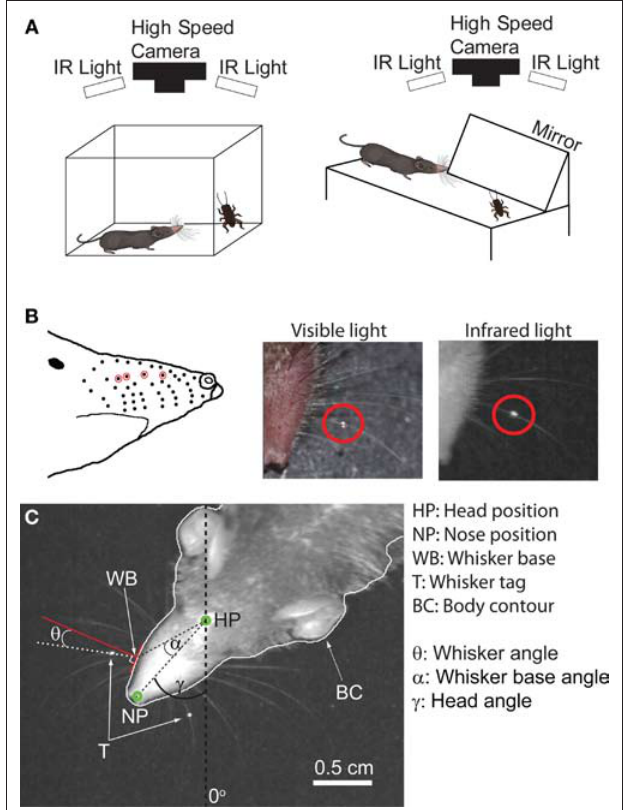
FigurE 1 | Behavioral setup and whisker tagging. (A) Left: Behavioral setup for filming free hunting. Shrews were filmed in an arena (9 × 9 × 9 cm) from above (300-Hz frame rate). Movies were made under infrared (IR) illumination ( λ = 880 nm). Right: in this setup the cricket was fixed in place and a mirror placed at a 45 ° angle allowed for simultaneous filming from the top and side (B) Left: diagram of whisker positions on shrew snout, red circles denote whiskers which were targeted for tagging. Middle: picture of a tag under visible light, circled in red. Right: tagged whisker under infrared illumination. (C) Variables used for quantifying shrew head and whisker